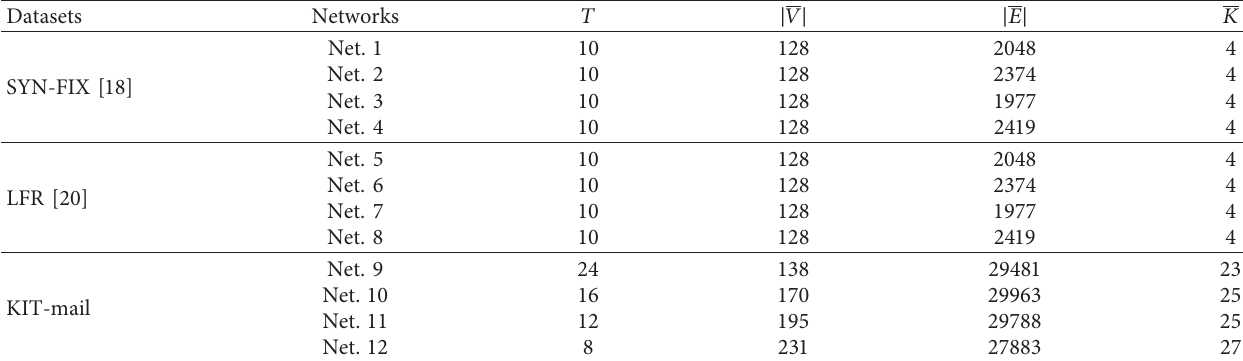
Table 2: Statistical information of dynamic